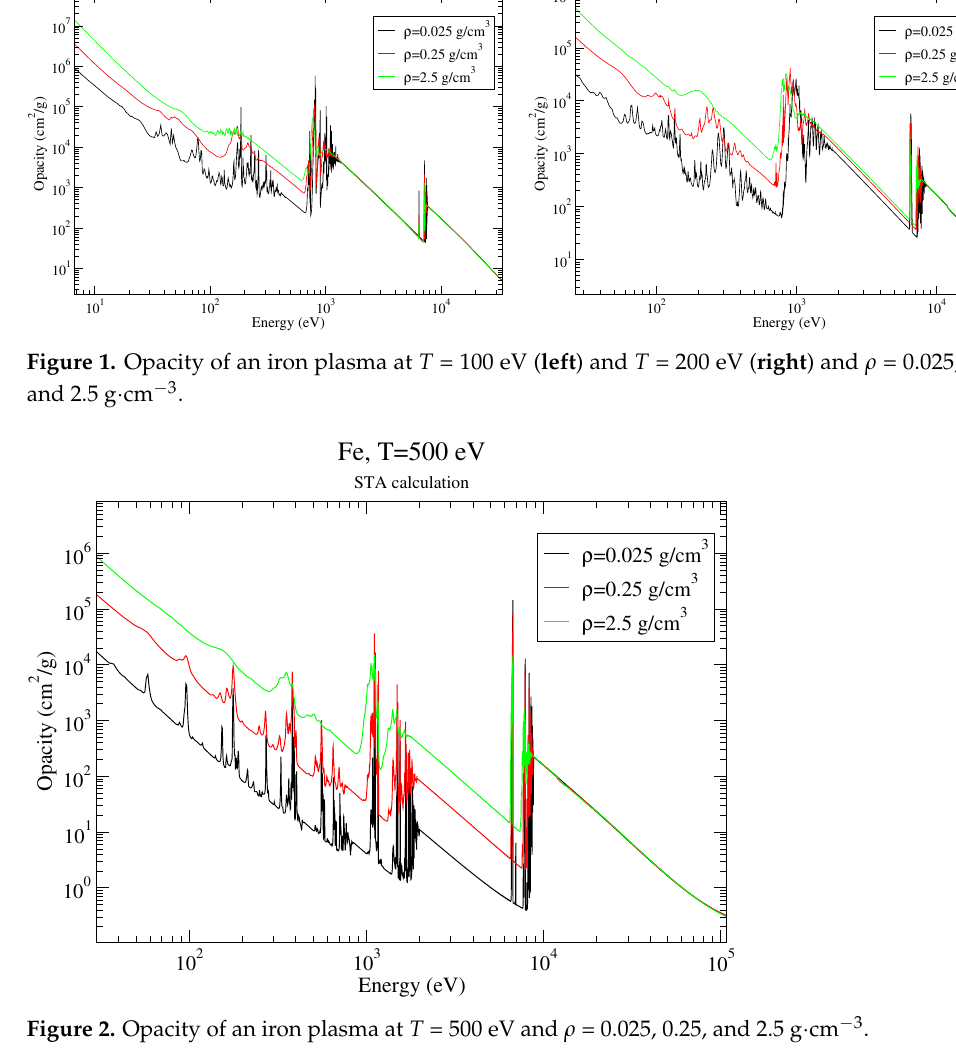
Figure 2. Opacity of an iron plasma at T = 500 eV and ρ = 0.025, 0.25, and 2.5 g